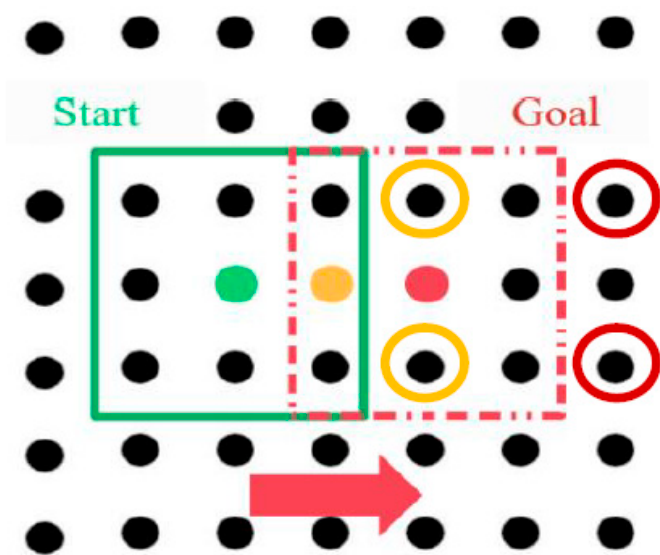
Figure 8. Motion of the micropart that is simulated in Matlab/Simulink.